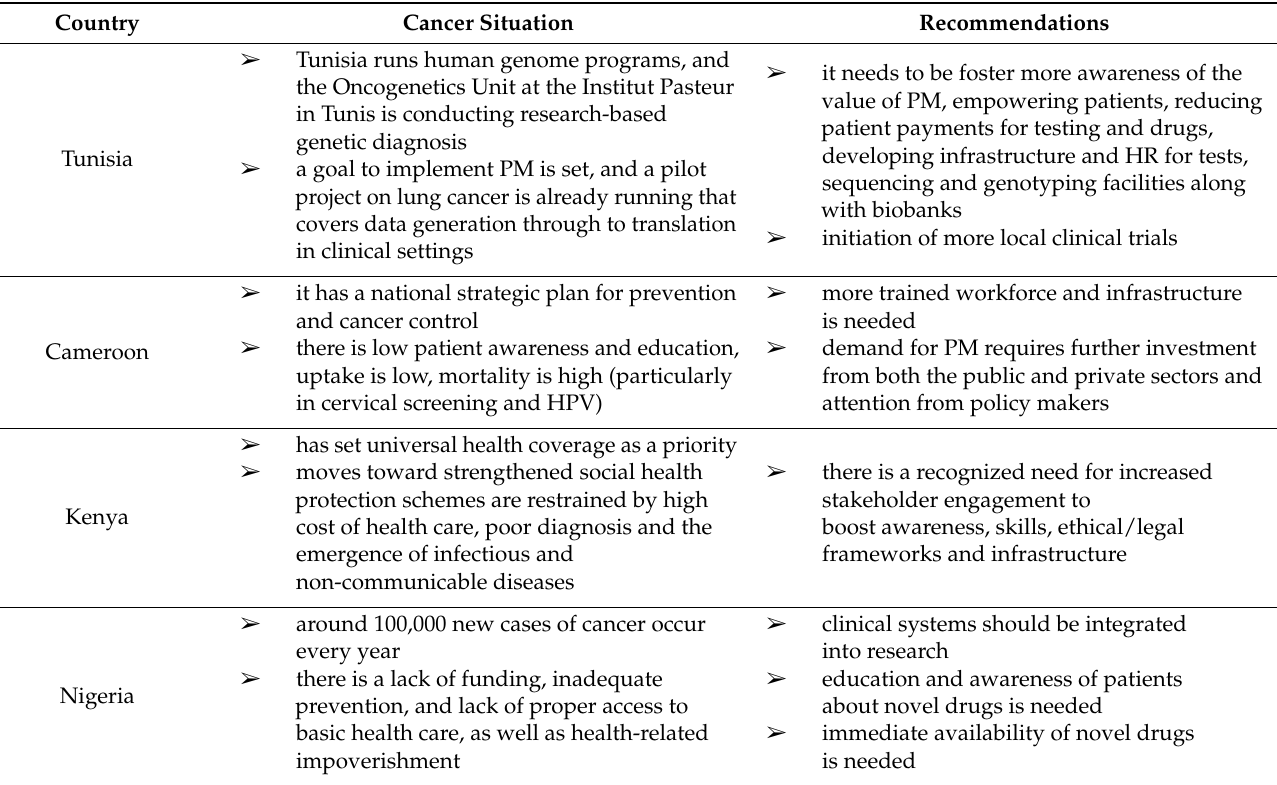
Table 3. Cancer situation and related recommendations in different African countries.